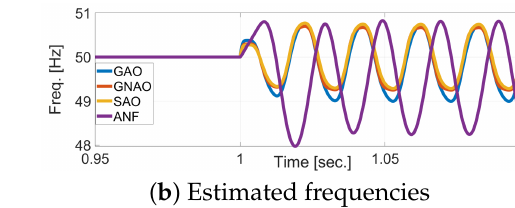
Figure 4. Numerical simulation results for Test-IV.